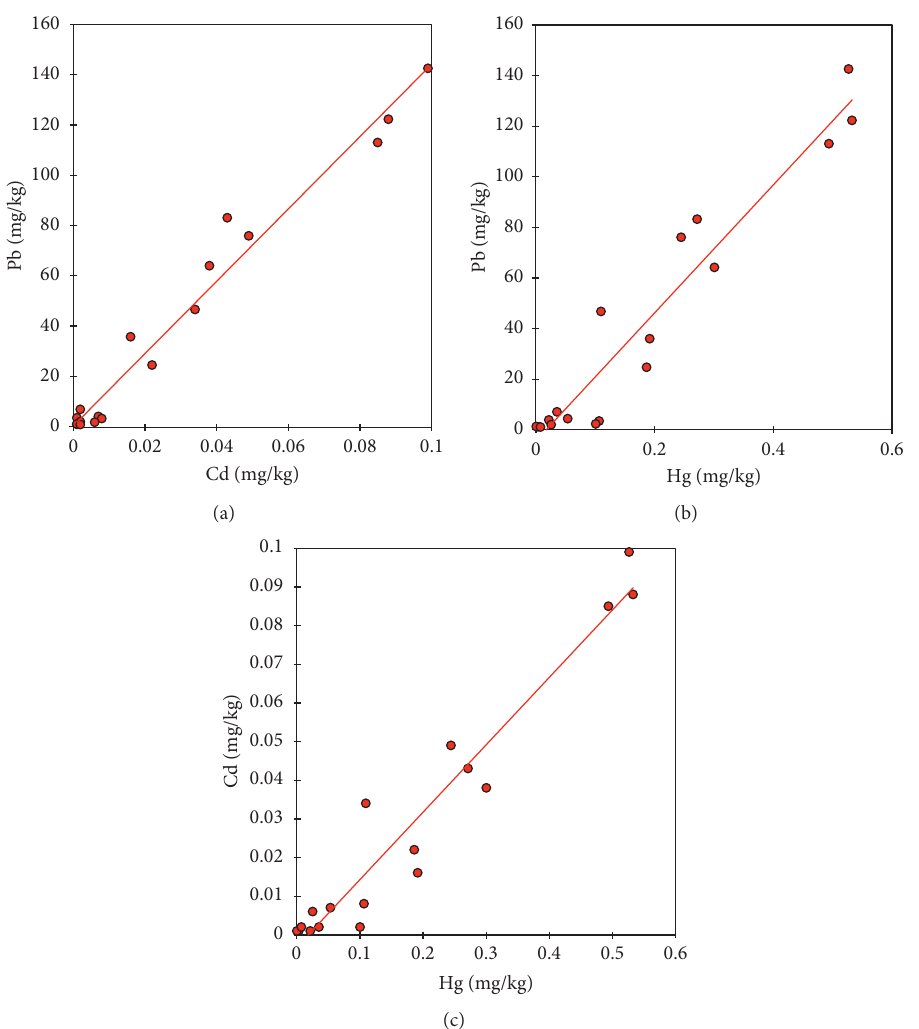
Figure 6: Interelemental correlation among toxic metals within blood of rats showed strong positive correlation ( r > 0.90) between metals such as (a) Cd and Pb, (b) Hg and Pb, and (c) Hg and Cd during the study. All correlations were significant at p < 0 . 01.